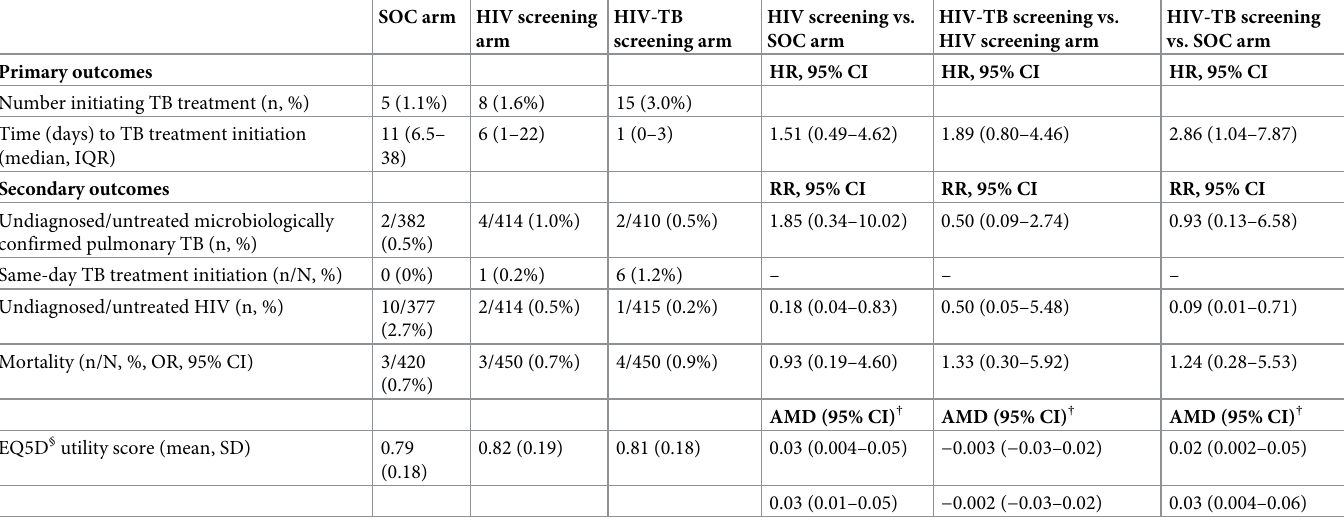
Table 2. Effect of interventions on trial